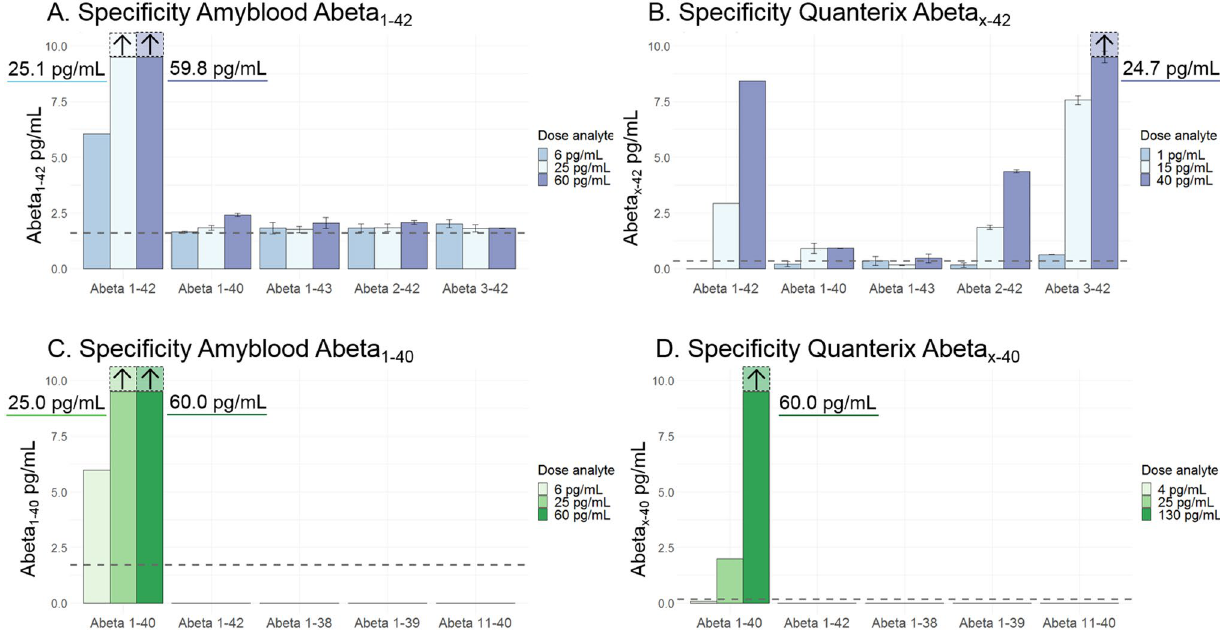
Figure 2. Specificity of the Amyblood and Quanterix assays. ( A ) Amyblood Abeta 1-42 concentrations were measured above blank reading for all abeta fragments, with a maximum of 2.4 pg/mL for 60 pg/mL of Abeta 1-40 for the fragments other than Abeta 1-42 . ( B ) Quanterix Abeta x-42 signal were measured above blank for Abeta 2-42, and Abeta 3-42 , with a maximum of 24.7 pg/mL for 40 pg/mL of Abeta 3-42 ( C ) No increase in Amyblood Abeta 1-40 signal was measured above blank reading for any of the Abeta fragments other than Abeta 1-40 . ( D ) No increase in Quanterix Abeta x-40 concentration was measured above blank reading for any of the Abeta fragments other than Abeta 1-40 . Dashed line represents the LLOQ per